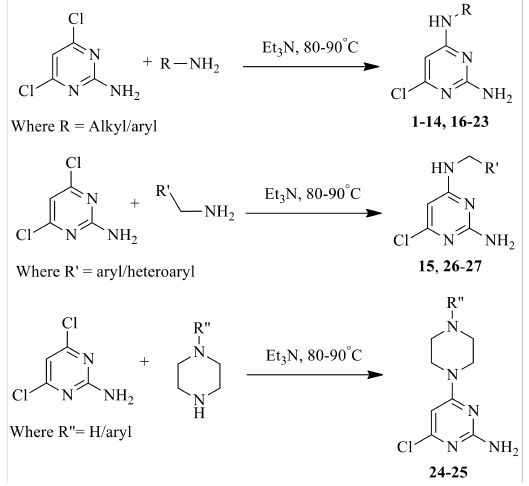
Scheme 1. Synthesis of 2-aminopyrimidine derivatives 1–27